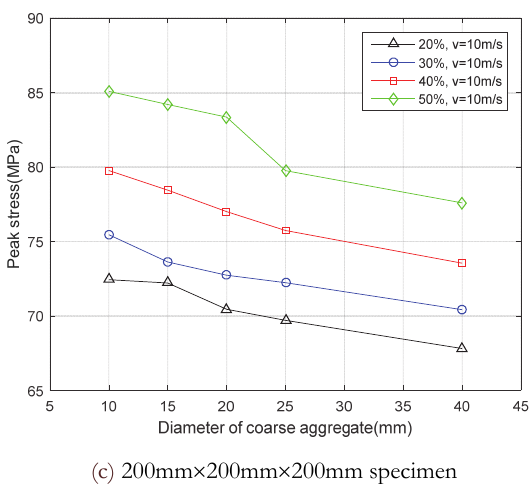
Figure 8: Relationship between maximum aggregate particle size and peak stress of